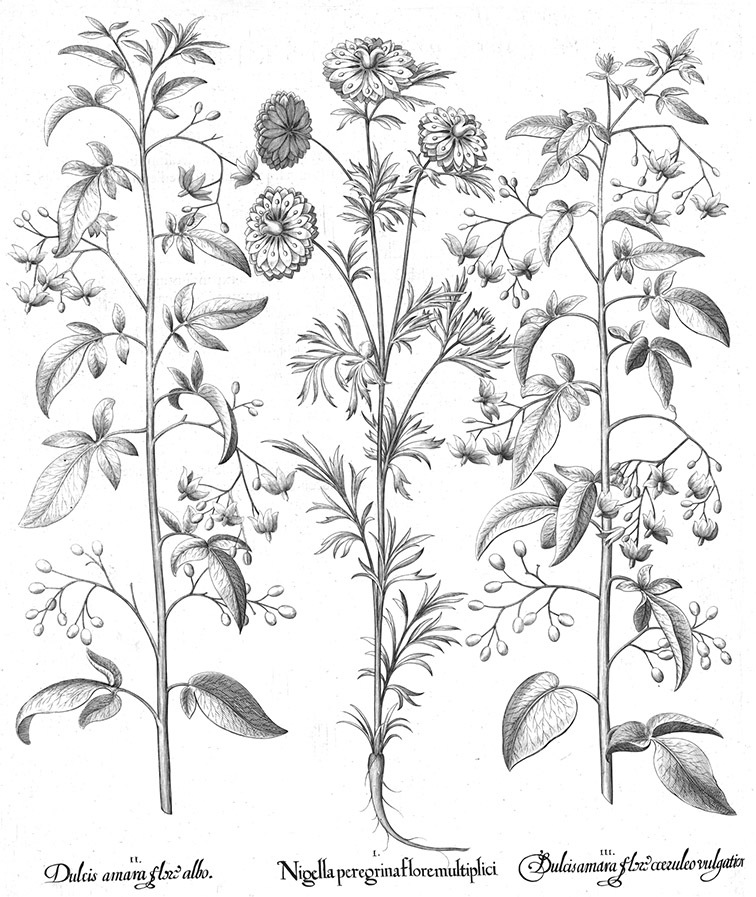
“Dulcis amara” from Hortus Eystettensis (Besler 1613). The centre plant is clearly Nigella (Ranunculaceae), but was described as a variety of Solanum dulcamara by David Don. Reproduced with permission of the Natural History Museum Botany Library.